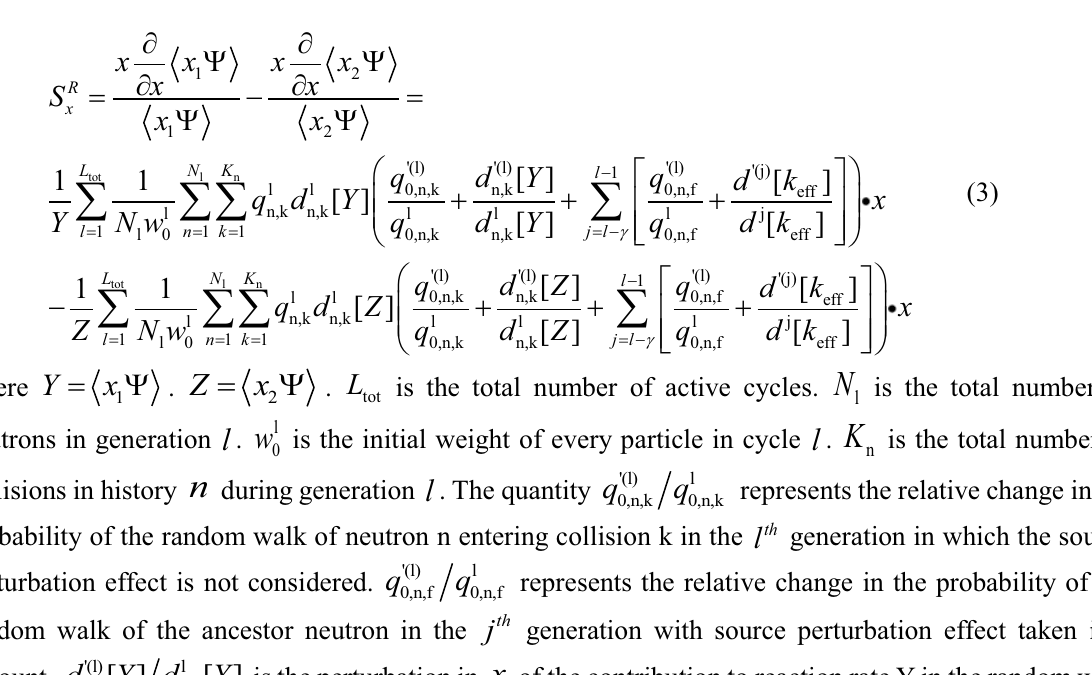
random walk of the ancestor neutron in the th j generation with source perturbation effect taken into